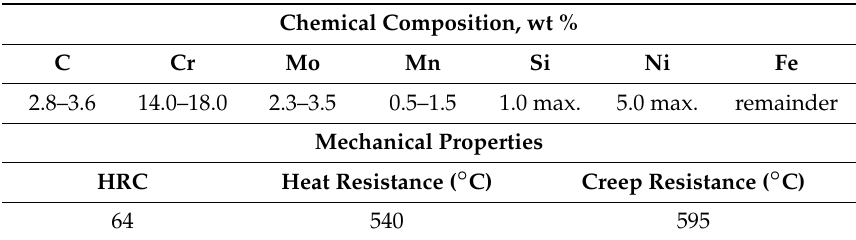
Table 2. Chemical composition and physical characteristics of the abrasion-resistant layer of